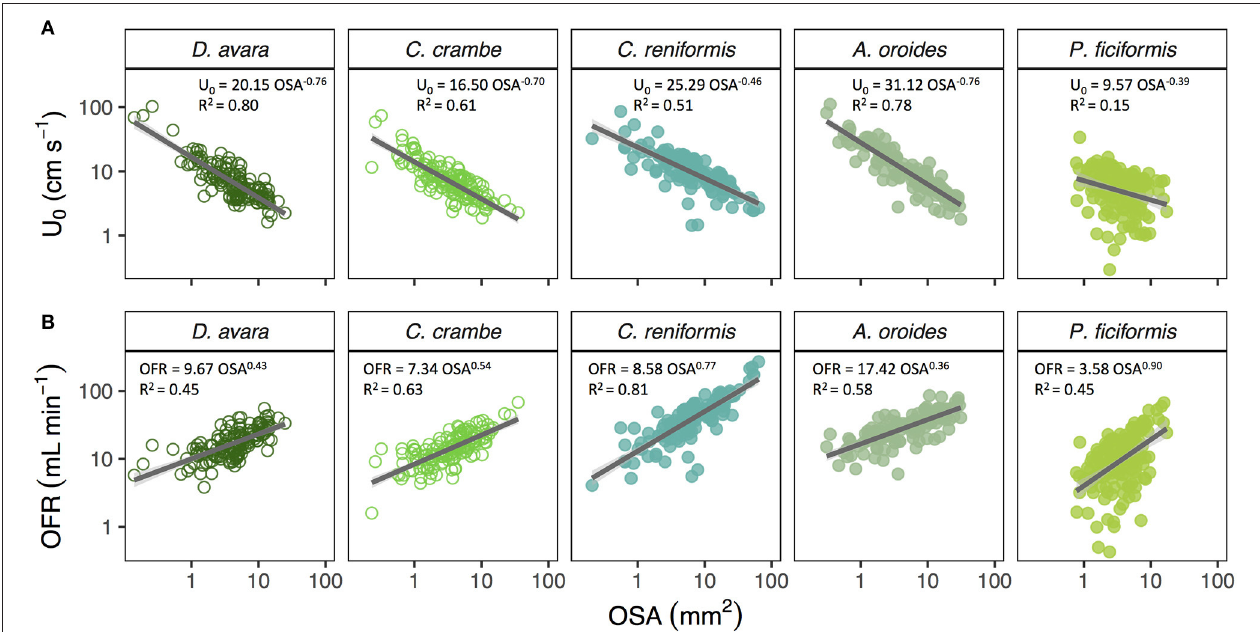
FIGURE 1 | (A) Allometric relationship ( Y = aX b ) between osculum jet speed (U 0 , cm s − 1 ) and osculum cross-sectional area (OSA, mm 2 ), and (B) osculum flow rate (OFR, mL min − 1 ) and OSA on multi-osculated specimens from the Mediterranean Sea: D. avara ( n = 139), C. crambe ( n = 147), C. reniformis ( n = 131), A. oroides ( n = 130), P. ficiformis ( n = 158). The allometric equations are shown in each panel and the shade areas represent the 95% confidence interval for the regression line. The b scaling exponents were statistically different from zero for all species ( p < 0.001). Note the log-log